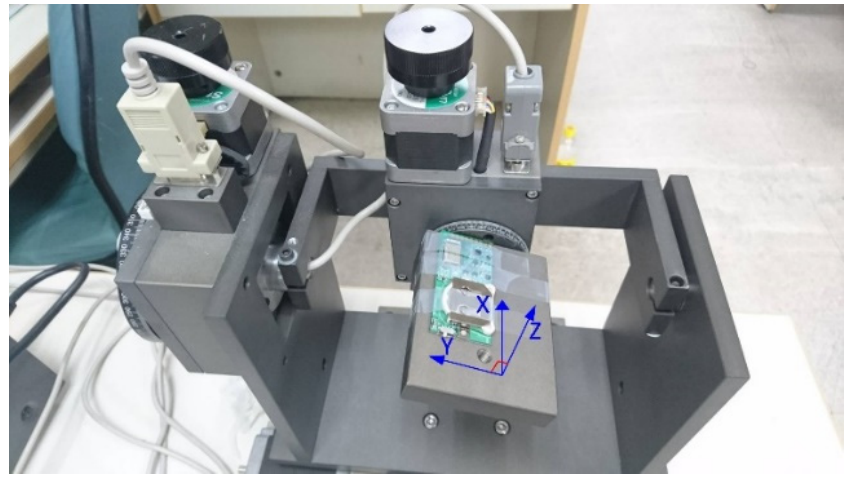
Figure 9. Tilt angle verification (rotating on accelerometer x -axis). From the initial position, the platform rotated 360 ◦ clockwise at 15 ◦ steps about its center axis (i.e., x -axis of the BASIC module). The platform was maintained at each rotation step for more than 4 s to ensure that at least 100 consecutive acceleration and tilt angle data points could be recorded (e.g., by setting the sampling rate of the BASIC module to 25 Hz) and averaged. Acceleration data for the X-, Y-, and Z-axes were used to calculate the tilt angles θ , Ψ , and Φ (Cartesian coordinate system) and θ and φ (Spherical coordinate system) to evaluate the accuracy of tilt angle detection and calibrate the module. Figure 10a shows a plot of the theoretical values of θ , Ψ , and Φ , where −π /2 ≦ θ , Ψ ≦ π /2, and 0 ≦ Φ ≦ π . Figure 10b presents a plot of the angle errors (for θ , Ψ , and Φ ) obtained with the differences between the theoretical values and calculated values using the raw accelera- tion data before calibration. Figure 10c presents a plot of the angle errors calculated using acceleration data after calibration. Figure 10d presents a plot of the theoretical values of θ and φ , where θ = π /2 and 0 ≦ φ ≦ π . In this verification process, because the platform was rotating about the x -axis, the projective gravity forces on the X–Y plane of the accelerom- eter were always aligned with the y -axis. Therefore, the theoretical values of the angle θ were π /2 (i.e., 90°) for all rotation steps. Figure 10e presents a plot of the calculated angle errors ( θ and φ ) with the theoretical values obtained using the raw acceleration data be- fore calibration. Figure 10f shows a plot of the angle errors calculated using data after calibration. The horizontal axes of all plots in Figure 10. indicate the rotation angles of the testing platform. The vertical axes indicate the angle values in Figure 10a,d and the errors of the calculated angles in Figure 10b,c,e,f. The errors of the tilt angles calculated using acceleration data calibrated through the methods described in Section 2.4, Figure 10c,f, are significantly lower than those calculated using raw acceleration data (without calibration; Figure 10b,e).